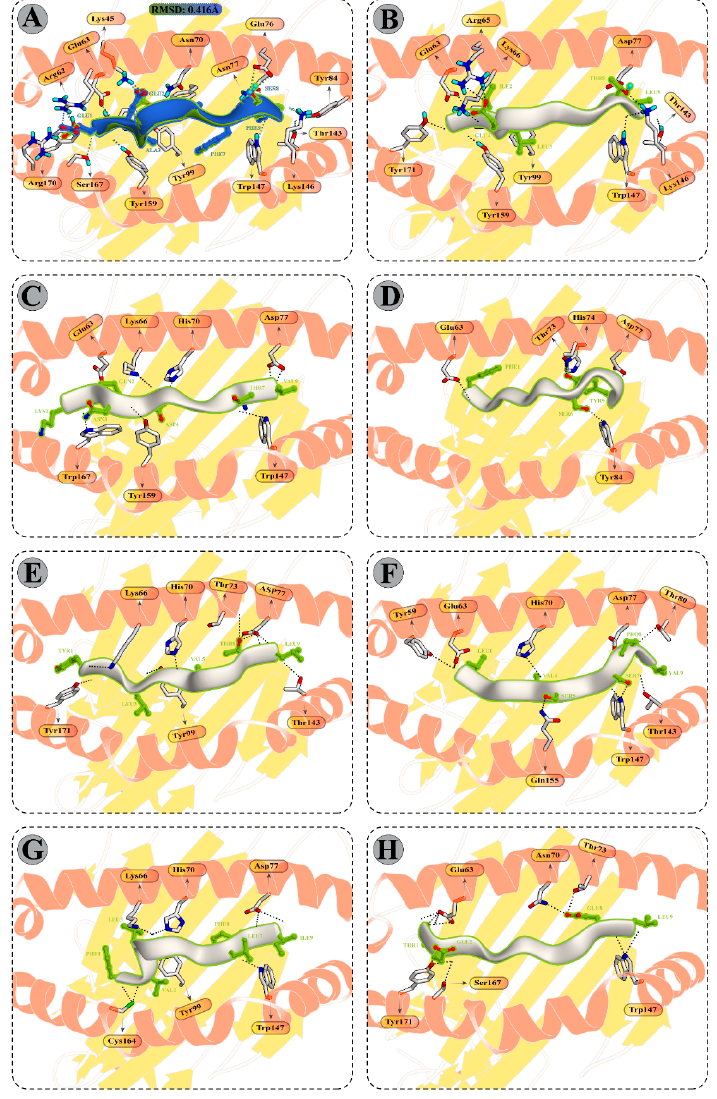
Figure 4. Molecular docking of CTL peptides and HLA class I molecules ( A ) Peptide EEAGRAFSF (Green) co-crystalized in the binding pocket of HLA-B*44:02 (PDB ID: 3L3D). The Blue peptide repre- sent the re-docked peptide. ( B ) Peptide GILEFVFTL (PDB ID: 5HHP) co-crystallized in the binding pocket of HLA-A*02:01. ( C ) Peptide KQNDRCTLV attached with the binding pocket of HLA-A*02:01. ( D ) Peptide FLFWFSFGY attached with the binding pocket of HLA-A*02:01. ( E ) Peptide YLLIVVGTL attached with the binding pocket of HLA-A*02:01. ( F ) Peptide LLTVSLSPV attached with the binding pocket of HLA-A*02:01. ( G ) Peptide FVLGSILFI attached with the binding pocket of HLA-A*02:01. ( H ) Peptide TEAIVCVEL attached with the binding pocket of HLA-B*44:02. All H-bonds are repre- sented in dotted lines and the interacting residues of HLA class II molecule is shown in stick.